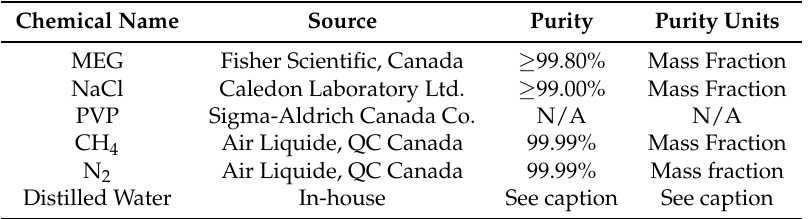
Table 1. Reagents used in this study. Resistivity was used as an indicator of water purity: at the source, it was measured to be 18 M Ω ·